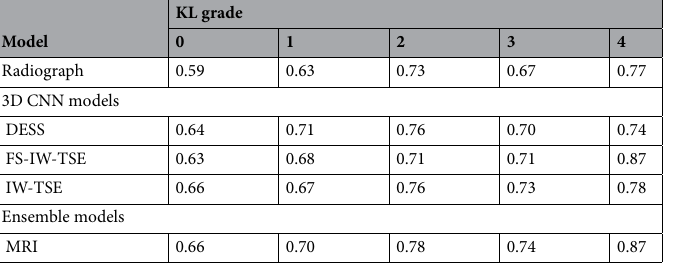
Table 5. Receiver operator characteristic analysis with areas under the curve (AUC) evaluating the diagnostic performance of the models to predict total knee replacement (TKR) using the internal hold-out testing group in the OAI database for knees with each individual Kellgren-Laurence (KL) grade. 3D Three-dimensional, CNN Convolutional neural network, CI Confidence interval, DESS Sagittal fat-suppressed three-dimensional